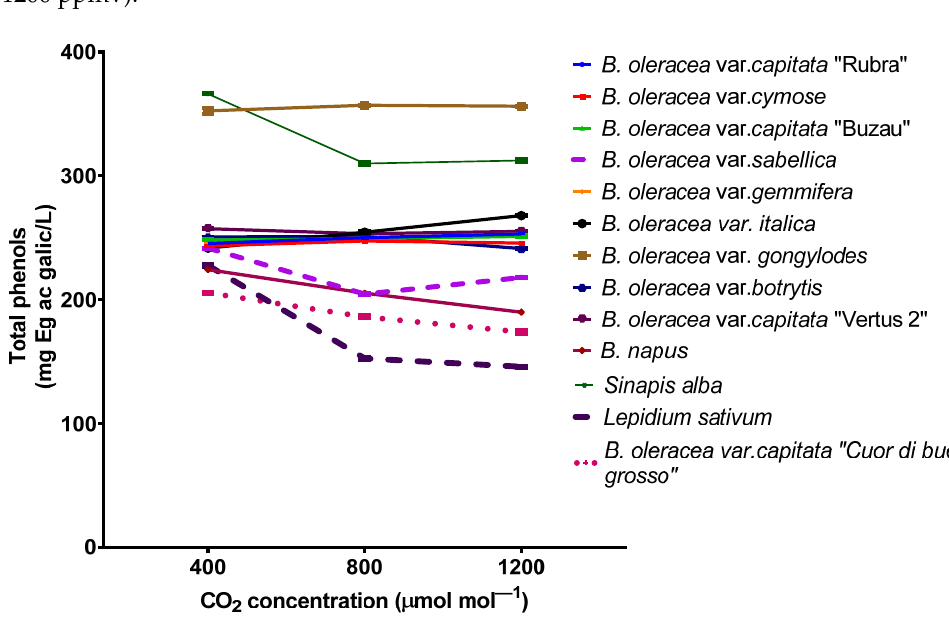
Figure 4. Total phenols concentration from Brassicaceae plants grown at three carbon dioxide concentrations. The values are averages of three independent measurements.